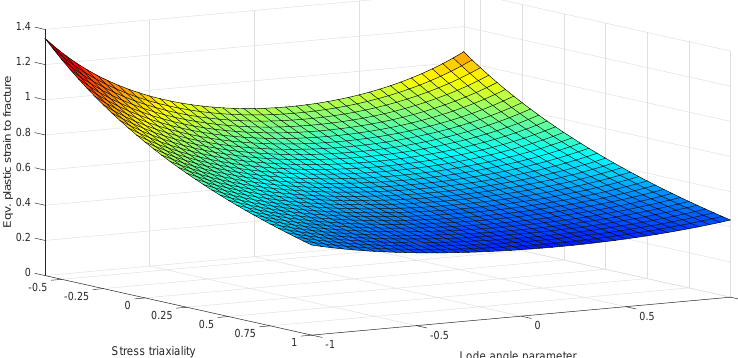
Figure 1. 3D fracture locus obtained using the proposed model with the parameters C 1 = 0.85, C 2 = 2.0, C 3 = 0.2. Figure 2 gives an example 2D plot of the fracture locus in the plane of ( ¯ ε p , η ) for several fixed